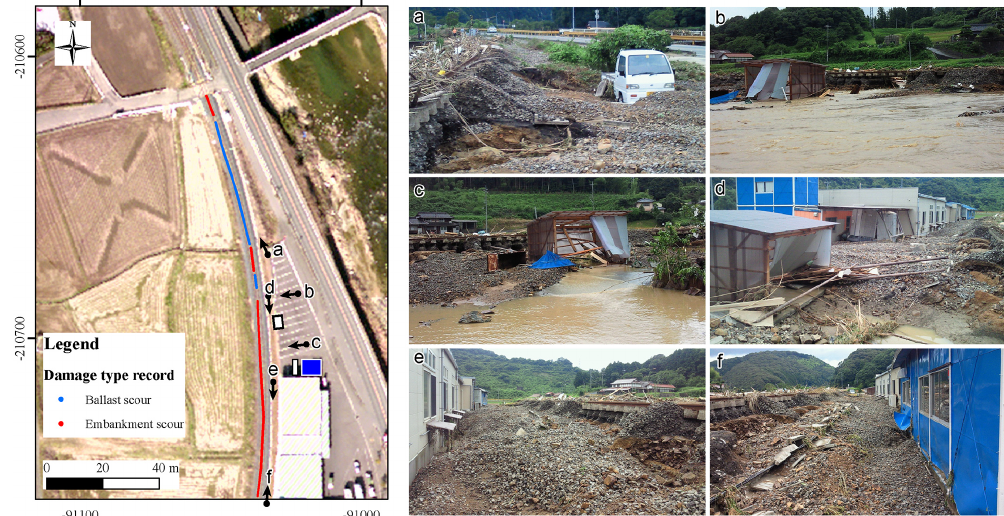
Figure 7. Example of the photos showing the status of the railway ballast–embankment scour just after the flood. Shooting location and direction of each photo are both plotted in the left orthorectified aerial photo taken in February 2012 (photo source: M.